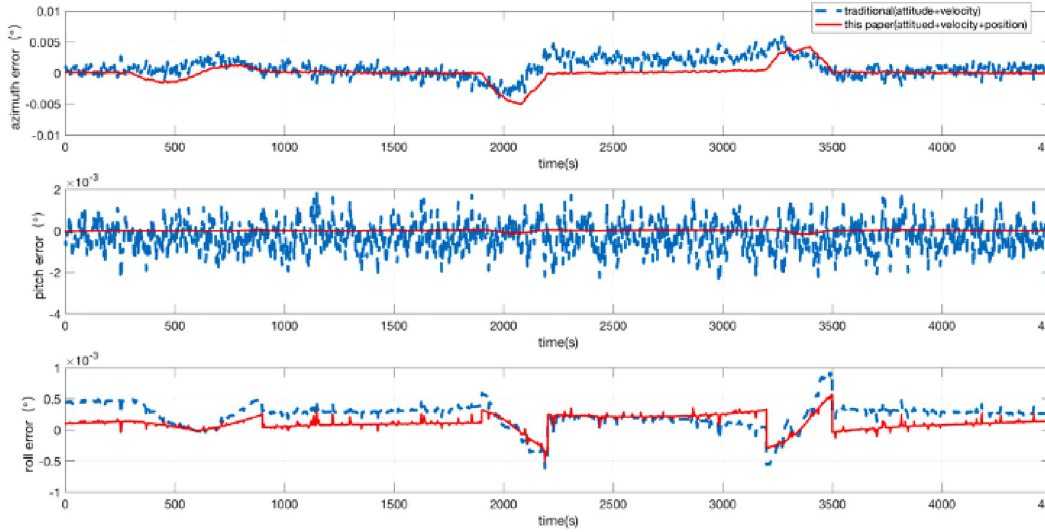
Figure 3. Attitude error of the POS.